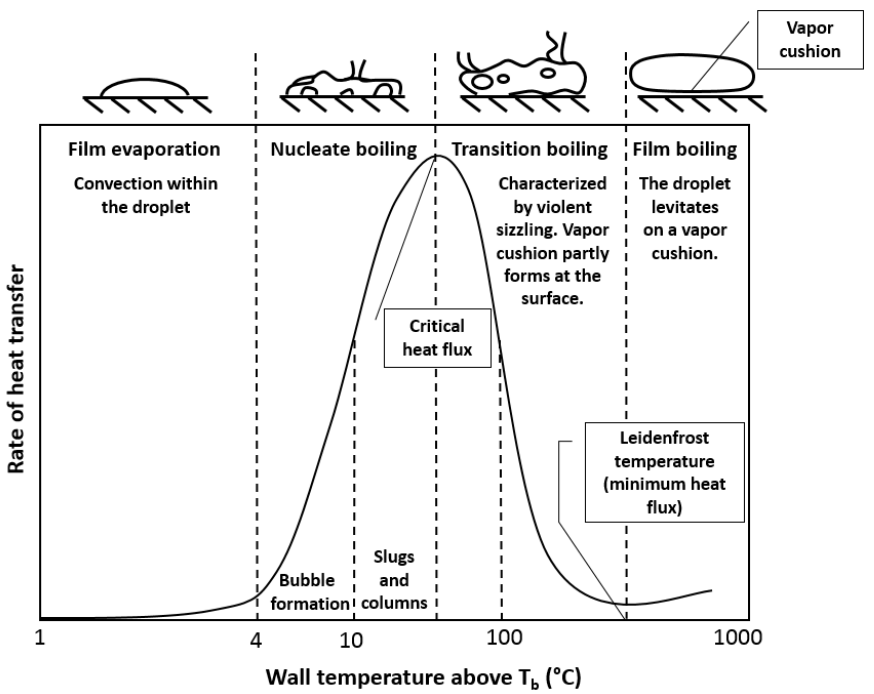
Figure 1. Droplet evaporation/boiling regimes: film evaporation, nucleate boiling, transition boiling, and film boiling. Adapted from [16,17,26].